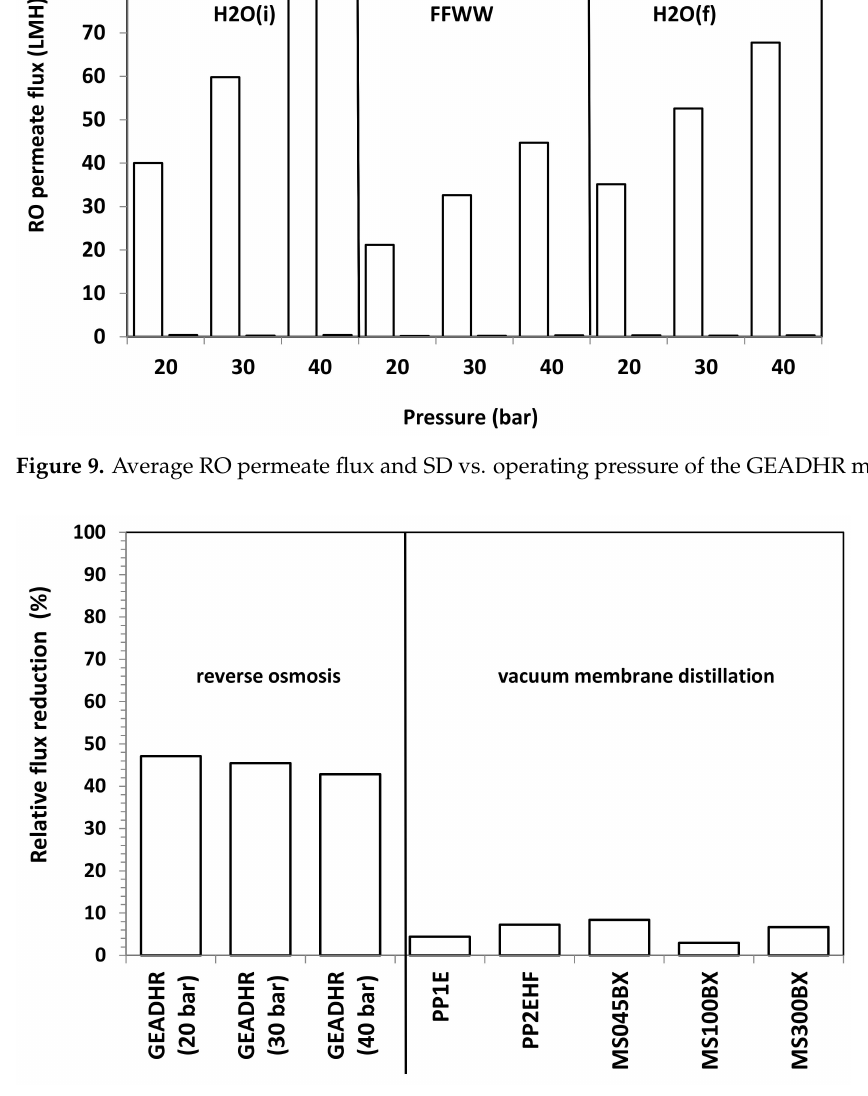
Figure 10. Relative flux reduction vs. operating pressure of RO and VMD